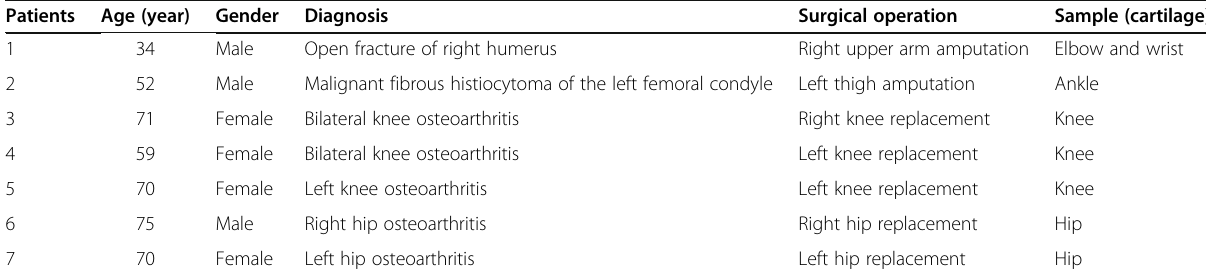
Table 1 General information of the patients